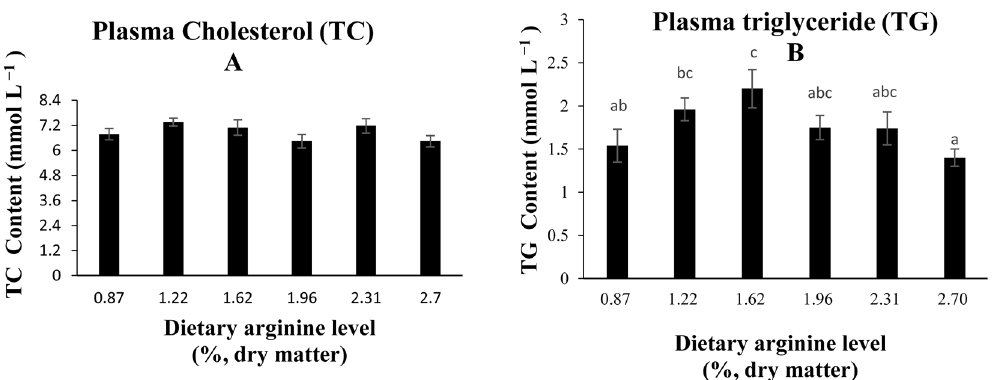
Figure 5. Plasma cholesterol ( A ) and triglyceride ( B ) contents of blunt snout bream fed diets with different arginine levels. Data are expressed as means with SEM. Value with different superscripts are significantly different ( P < 0.05